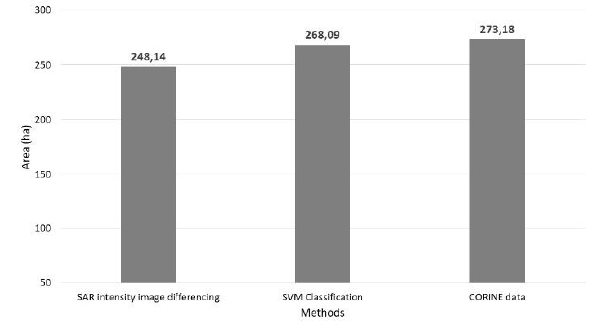
Figure 10. Correlation analysis between NDVI and calibrated SAR backscatter values. (a) 2016 (b) 2019.